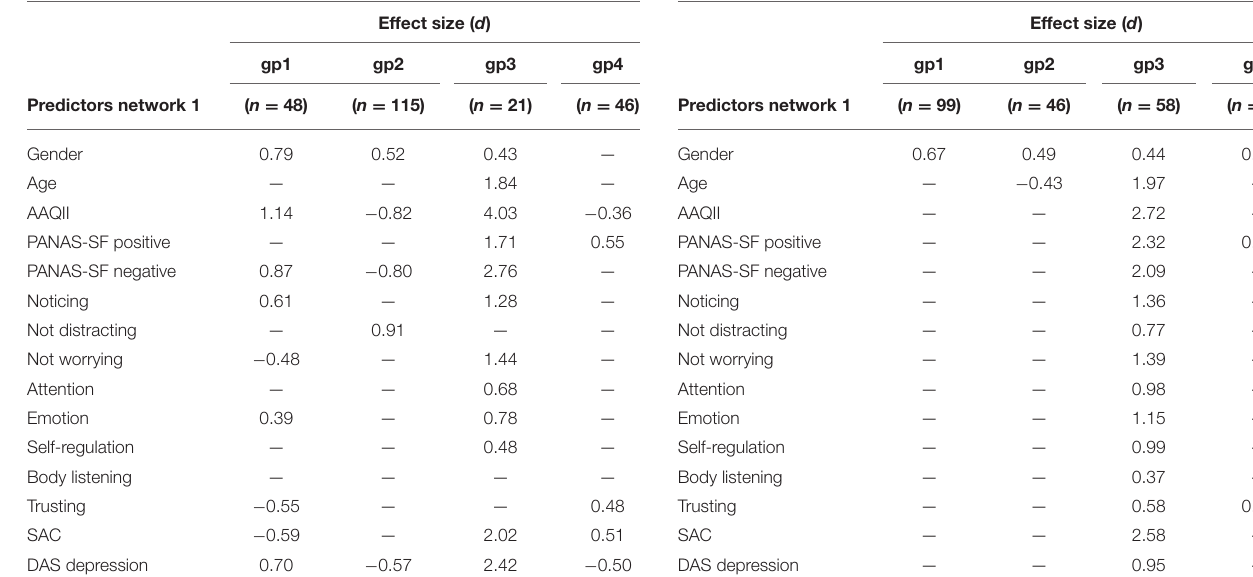
DAS anxiety DAS stress — — 1.07 Displaying effect sizes (d) when comparing similar cluster groupings with the average scores across the remaining groups. Sections which include a value below the minimum of small effect size (d = over ± 3.5) is depicted by a